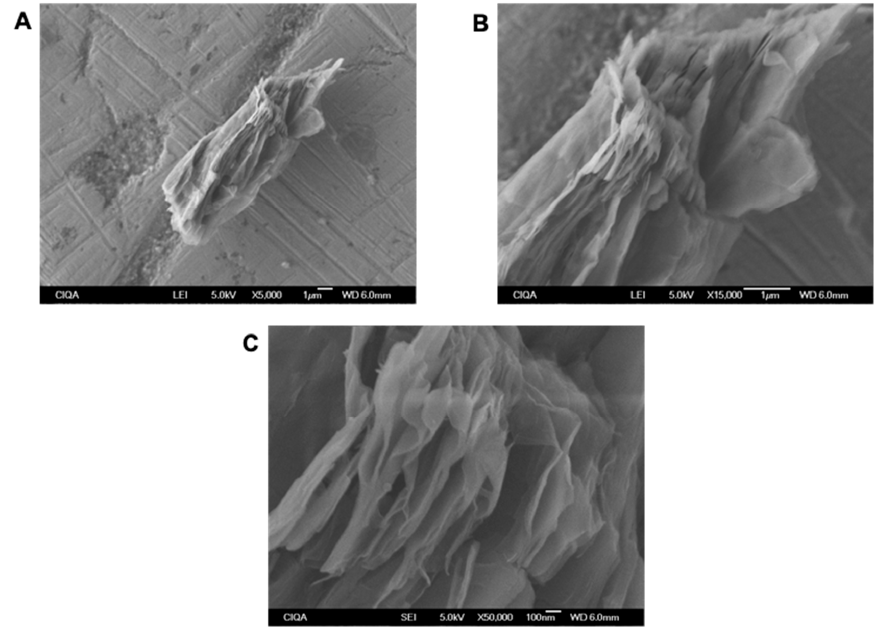
Figure 7. SEM micrographs of GrO at 5000 × ( A ), 15,000 × ( B ), and 50,000 × ( C